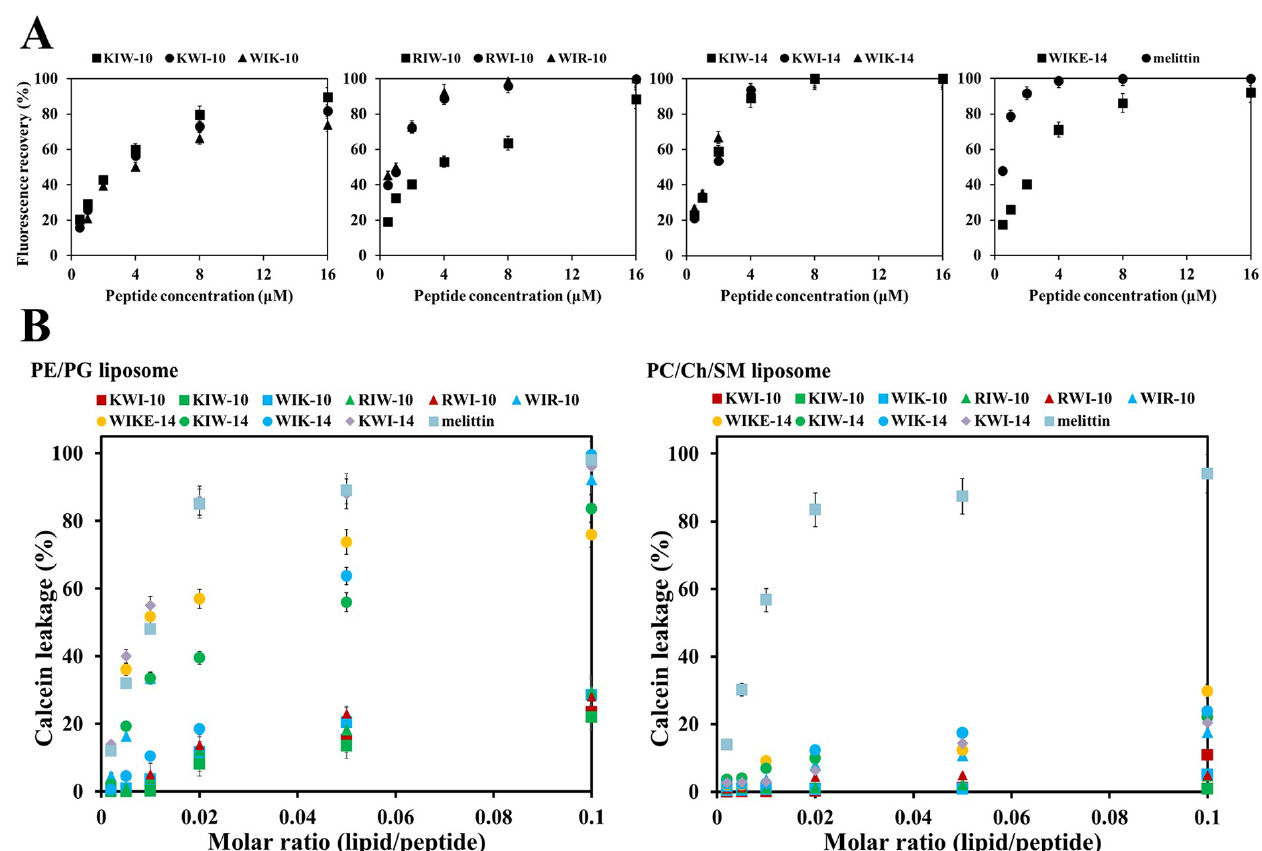
Figure 6. Peptide-induced depolarization of bacterial membranes ( A ) and calcein leakage from artificial liposomes ( B ). ( A ) The indicated peptides were added to intact E. coli ATCC 25922 that had been pre-equilibrated for 60 min with diS-C3-5. Fluorescence recovery was measured for 60 min (at 5 min intervals) after the peptides had been mixed with the bacteria. ( B ) Calcein leakage from calcein-entrapped small unilamella vesicles (SUVs) composed of PE/PG (7:3, w / w , bacterial membrane) and PC/Ch/SM (1:1:1, w / w / w , mammalian plasma membrane). It is not possible to selectively elucidate whether peptides act only on the cell